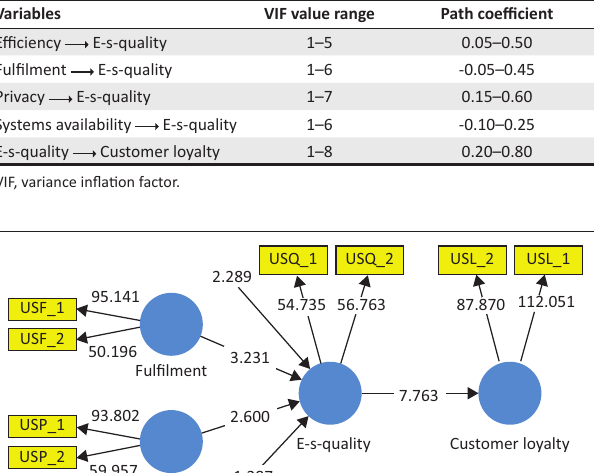
TABLE 5: Multicollinearity variance inflation factor path coefficients. Variables